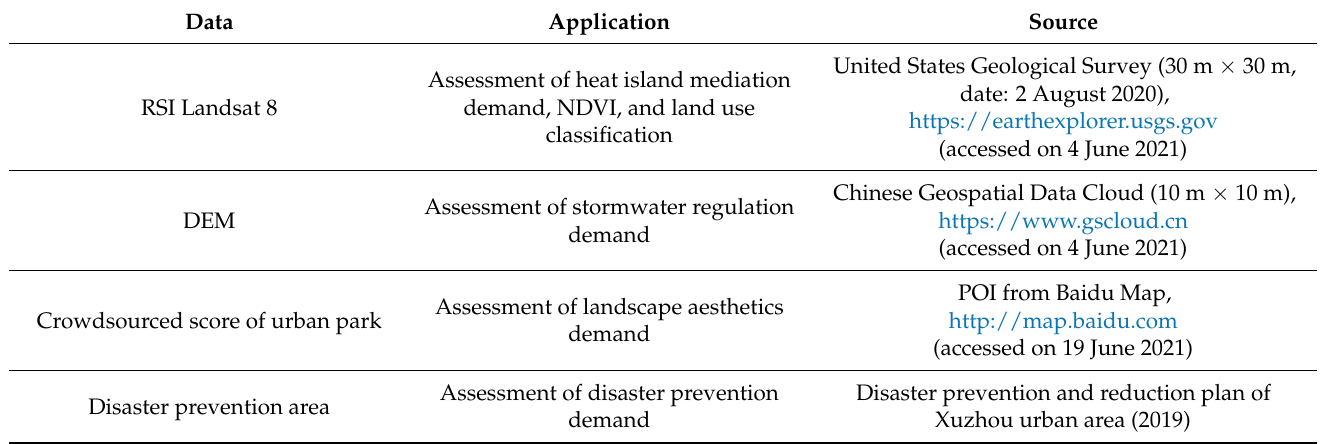
Table 1. Data used in the